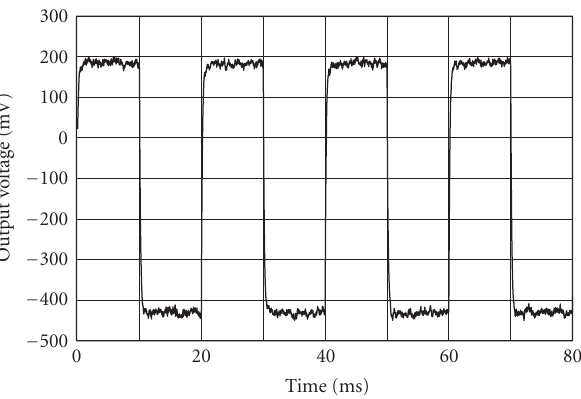
Figure 9: Voltage at the output of the integrator. The output sig- nal has the same frequency of the movement imposed for the heart wall. A time-varying surface with a period of 20 milliseconds has been considered for the simulation (this period is short with respect to the real heart moving, in order to reduce the simulation time. This does not impair the analysis since the radar reaches widely the steady state within ten milliseconds).